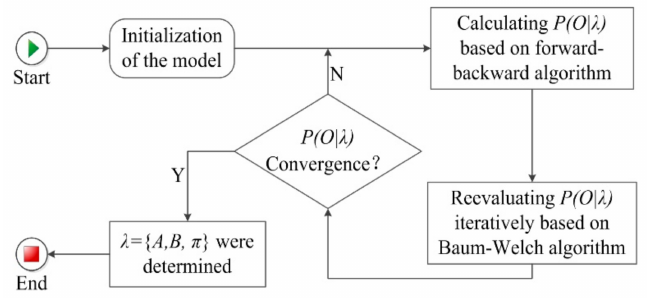
Figure 5. Model training